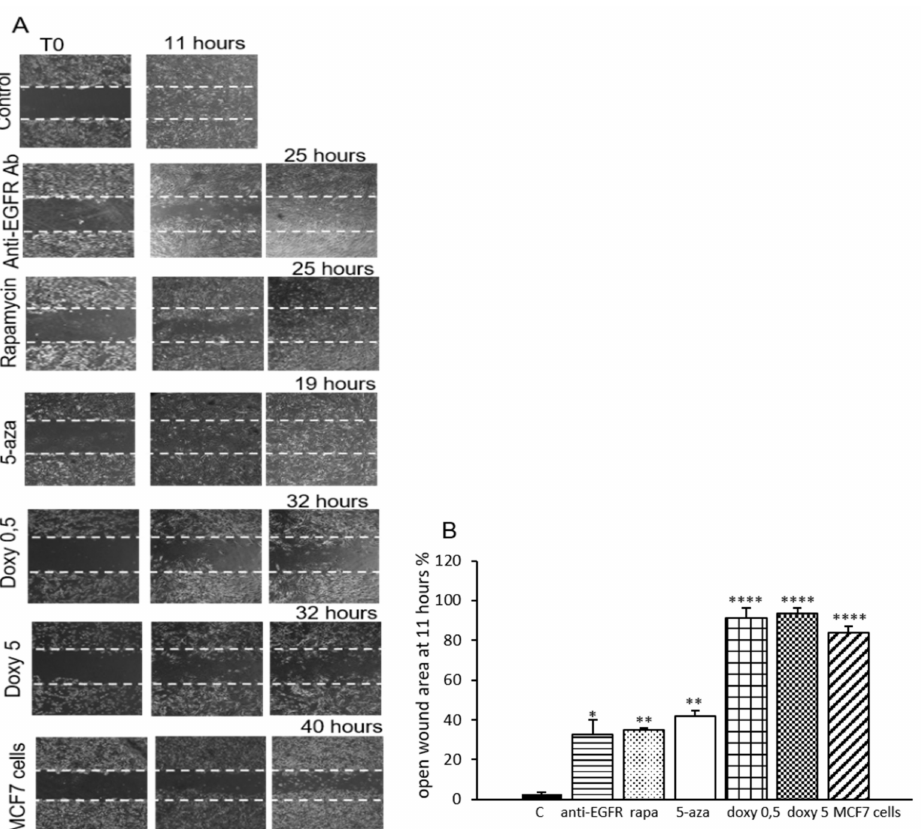
Figure 4. Migratory capability of LAM/TSC cells related to anti-EGFR antibody, rapamycin, and 5-azacytidine. ( A ) The figure shows representative images of LAM/TSC cell migration in a wound healing assay, following incubation with anti-EGFR antibody (anti-EGFR Ab; 5 µ g/mL for 48 h), rapamycin (rapa; 5 ng/mL for 48 h), doxycycline (0.5 and 5 µ M for 48 h), and 5-azacytidine (5-aza; 1 µ M for 96 h) compared with migration of MCF7 cells. The lines of each panel indicate the initial wound (0 h; left panels of each set: T0). Phase contrast microscopy (magnification 10 × ). ( B ) Cell migration during wound healing was quantified 11 h after the wound by measuring the distance in pixels using ImageJ software. ANOVA with Tukey test ± SEM ( n = 3 experiments) * p < 0.05; ** p < 0.01; **** p <